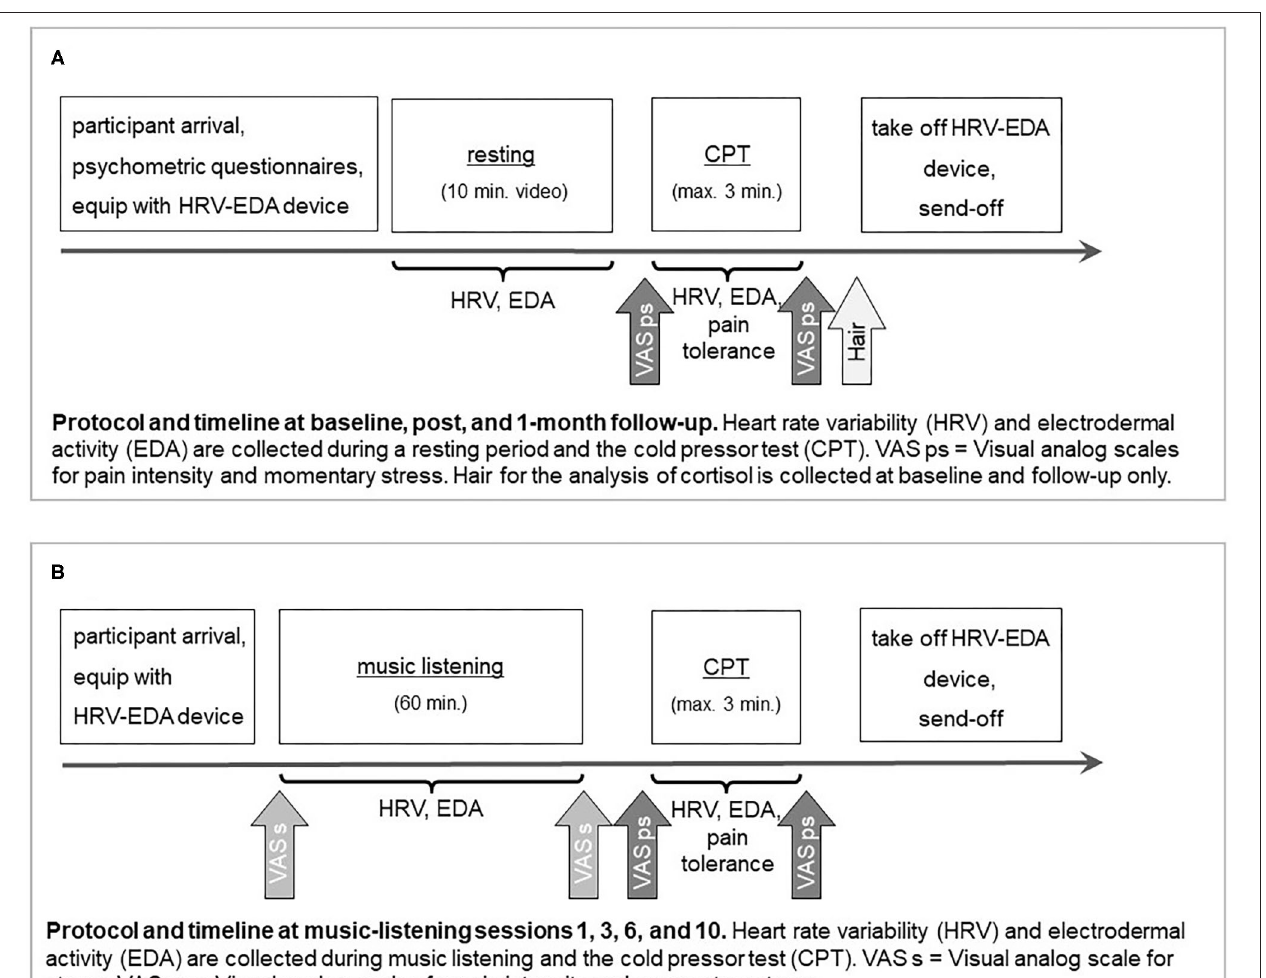
FIGURE 2 | Protocol and timeline for study appointments: (A) baseline, post, and follow-up, (B) music-listening sessions 1, 3, 6, and 10.